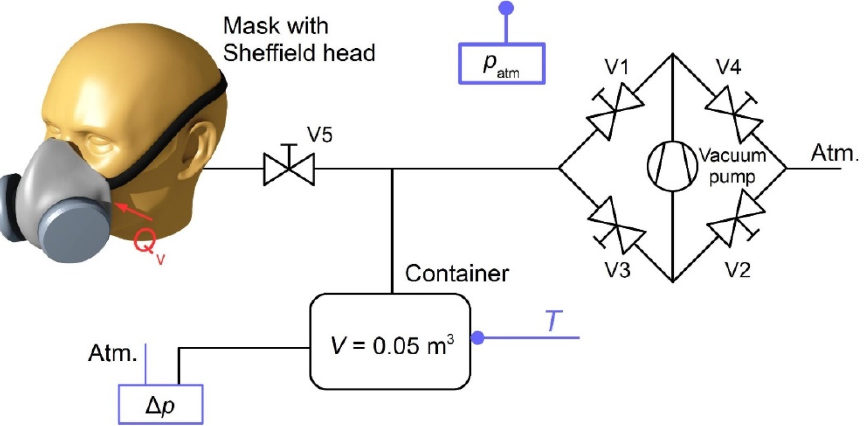
Figure 1. Scheme of individual components of the system measuring the respirator inward leakage in the facepiece area.